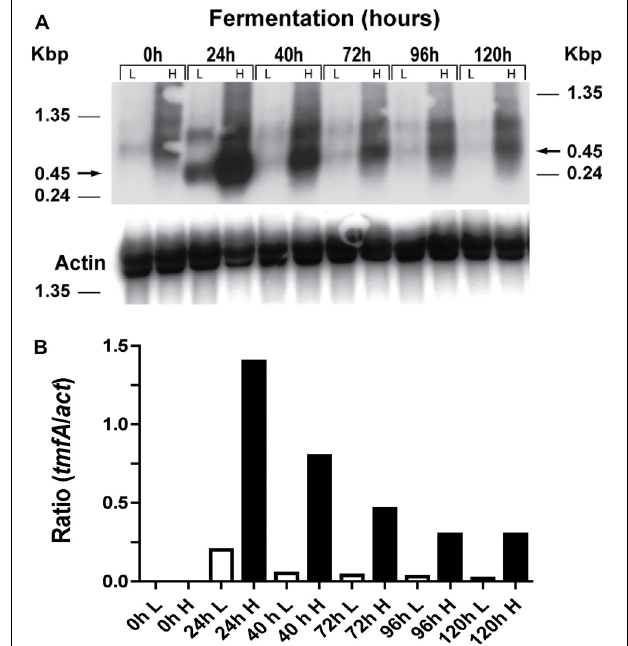
FIGURE 6 | Northern blot analysis of KM71H- gfp-tmf A cells (#5 and #22, low and high copy, respectively) that were fermented by shake flask for 0–120 h. (A) Total RNA (3 µ g/lane) was analyzed using a specific probe amplified by PCR ( Table 1 ). The size of the RNA markers is given on the left and the tmf A transcript (450 bp) is shown by an arrow on the right. (B) Scanned tmf A transcript blots (see a above) after different hours of the fermentation (0–120 h) of high and low copy colonies engineered with tmf A were compared with act transcript as a reference gene and the transcript ratios of tmfA/act were compared for cell that were engineered with 10 and 1 tmf A genes, respectively. White bars represent cells expressing a single tmf A and black bars cells expressing 10 tmf A genes. L = low copy colony #5 and H = high copy colony #22. The Northern blot analyses were repeated two times showing the same